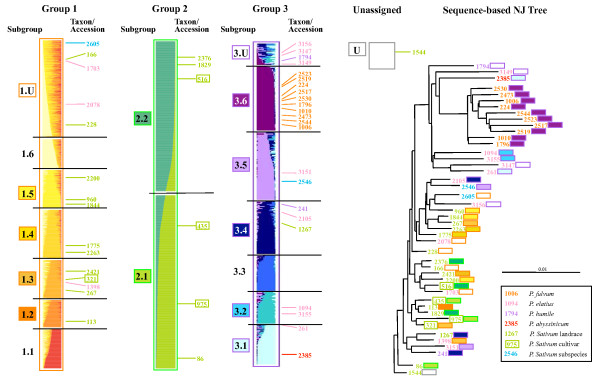
Relationships between RBIP-based Structure Sub-Grouping and sequence-based tree structure. Accessions assigned to Sub-groups of the three K = 3 Groups (see Figure 4) are shown on a previous neighbour joining tree based on intron sequence [adapted from [17]]. Subgroup assignments are indicated by box fill colours, Group assignments are shown by box outline colours and taxonomic (species/sub-species) assignments by colour coded text, using colours from Figure 4. 'Unassigned' Subgroups U, 1.U and 3.U (white boxes) are comprised of accessions with no founder genotypic contribution of 50% or more in the corresponding Structure run. Subgroups not represented in the tree (Subgroups 1.1, 1.6 and 3.3) are unboxed.